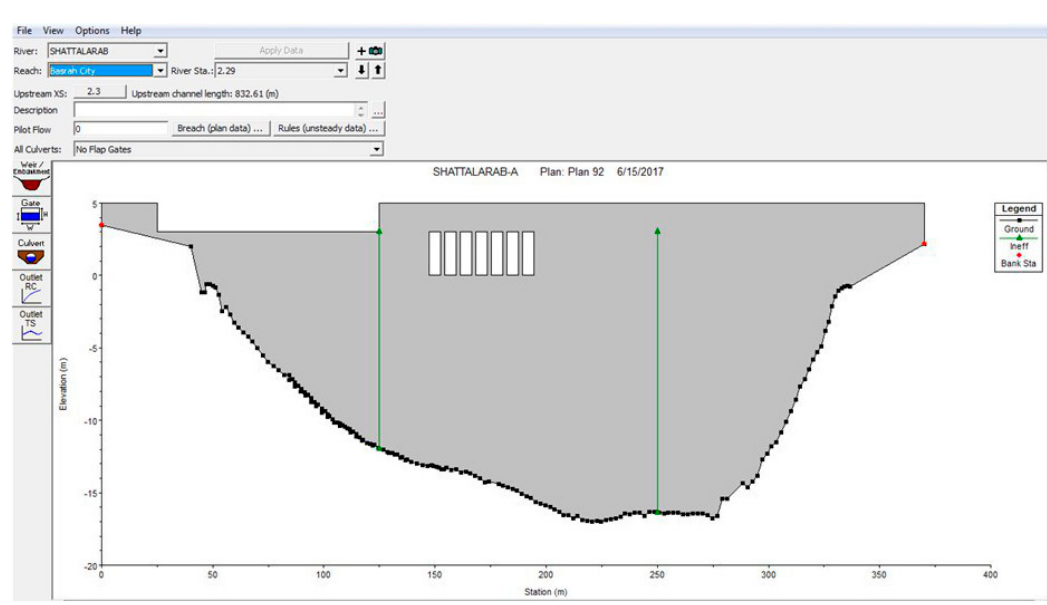
Figure 12. Inline structure data.